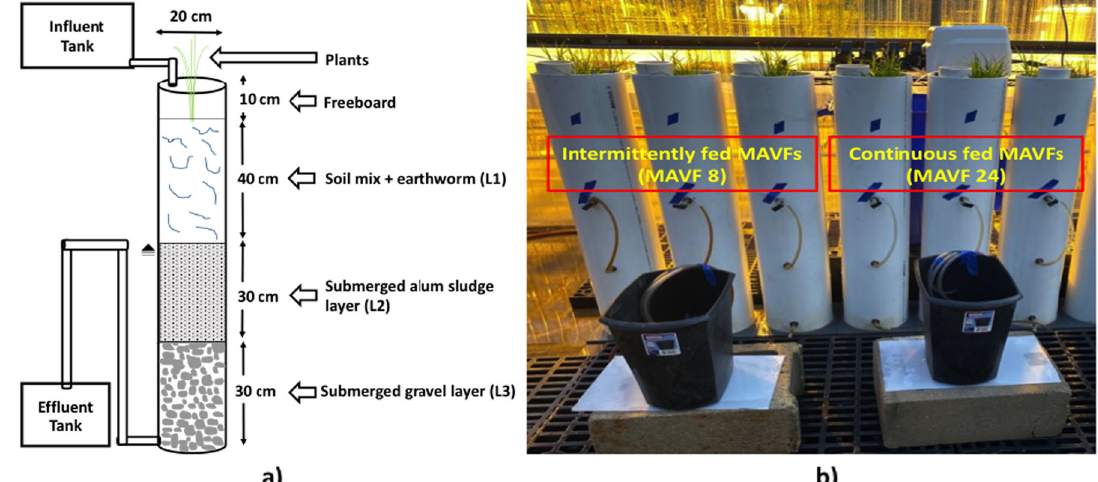
Fig. 5 Experimental setup. a Schematic. b Actual treatment setup. IMAVF Intermittently fed macrophyte assisted vermi fi ltration. CMAVF Continuously fed macrophyte assisted vermi fi ltration]. Three layers placed at 0 – 30 cm (L3), 30 – 60 cm (L2), and 60 – 100 cm (L1) from the bottom, containing gravel, alum, and soil mix,